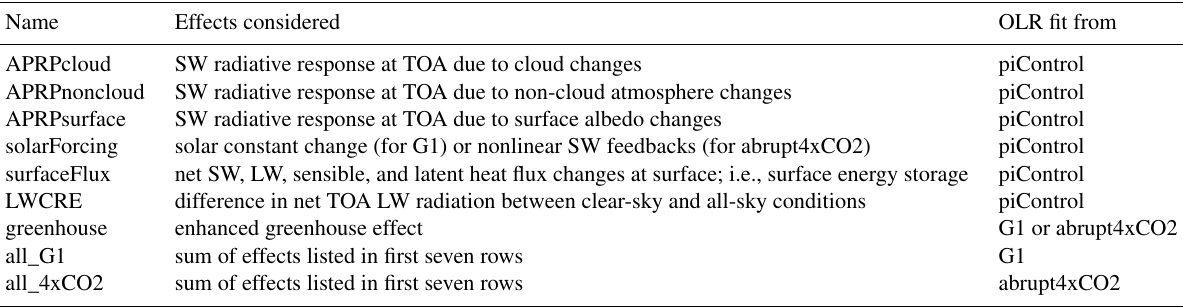
Table 2. Summary of attribution experiments run with the moist energy balance model.